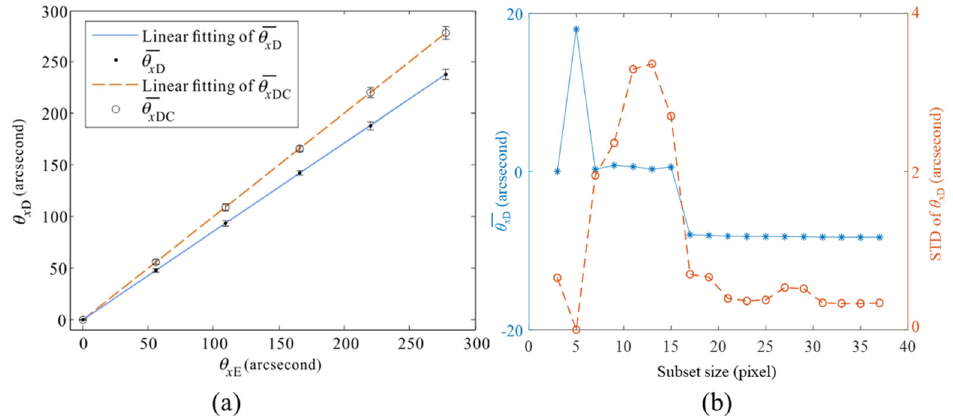
Figure 4. Rotational angle measurement results. ( a ) The results θ x D measured with DeSDIC are plotted against θ x E measured with the encoder. The subset size in DeSDIC was optimized to 21 × 21 pixels. θ is the average of θ x D and the error bar shows the standard deviation of θ x D at all the valid pixels inside the DM clear aperture. θ x DC is θ x D after correction of the systematic error. The linearity between θ x D and θ x E is nearly 1 and the slope before and after the correction is 0.86 and 1.00, respectively. ( b ) The optimization of subset size in DeSDIC.